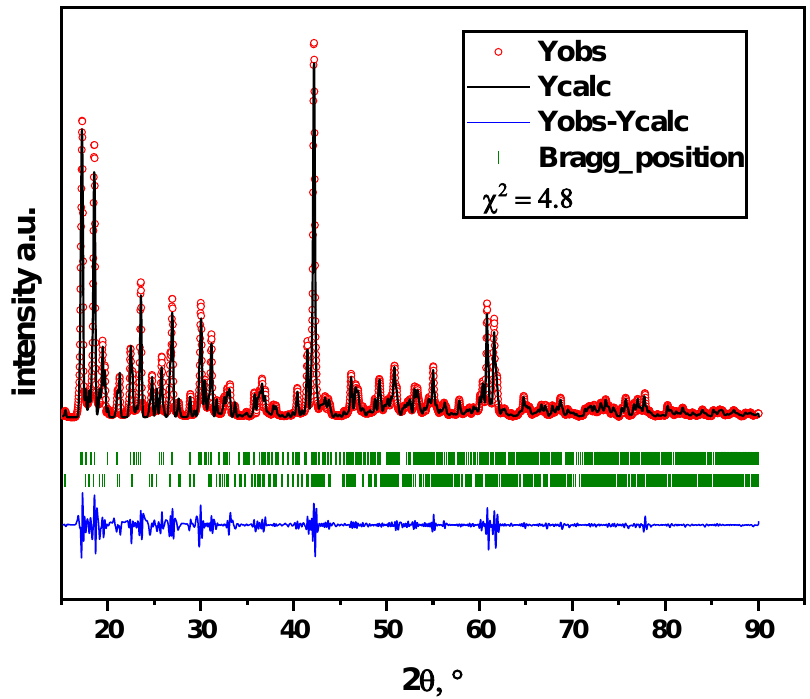
Figure 3. Rietveld refinement of powder XRD pattern for Li 6 Zr 2 O 7 sintered at 900 °C for 8 h. Dots represent the observed data, solid line marks the calculated data. Short green ticks indicate the peak positions of Bragg reflections; the upper row of short green ticks marks the monoclinic phase; the lower row of short green ticks marks the triclinic phase. The bottom line indicates the difference between the calculated and observed data.